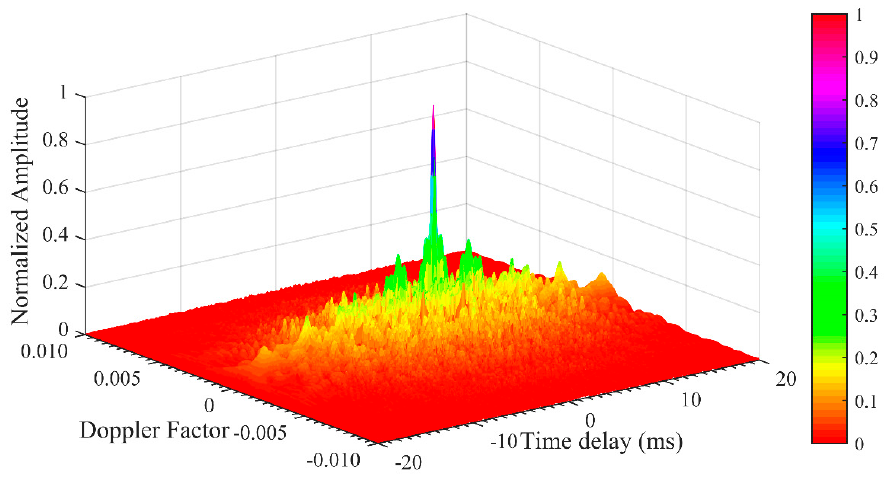
Figure 7. Ambiguity function of a humpback whale song.